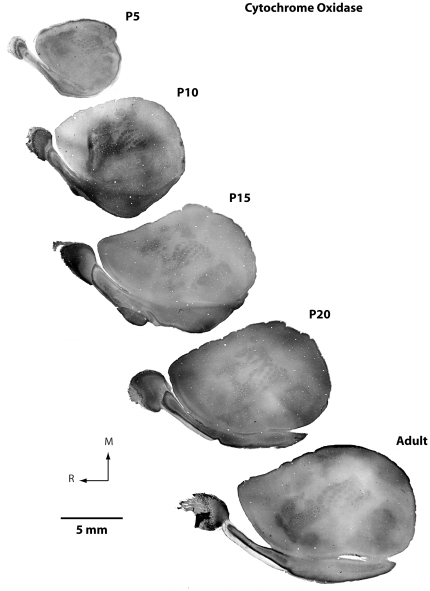
Appearance of cytochrome oxidase stained cortical tissue across development.Photomicrographs of cortex that has been flattened, sectioned tangentially and then stained for CO in P5 (top) through adult (bottom) subjects. Portions of the primary sensory areas, especially somatosensory cortex, are visible in all sections, but individual sections do not show all of the boundaries of a field. Images were imported into Adobe Photoshop and levels were adjusted to increase contrast. In all photomicrographs, medial is to the top and rostral is to the left.